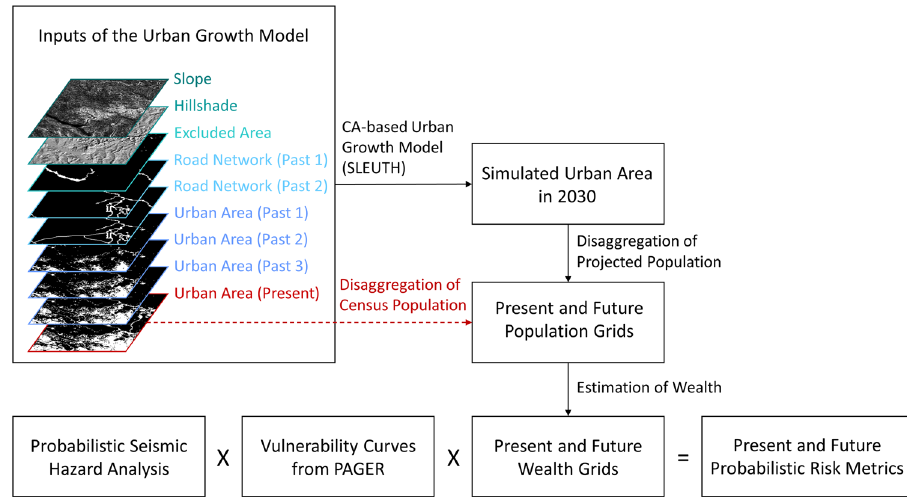
Fig. 1 Proposed framework for the estimation of present and future probabilistic seismic loss metrics using a macro-level approach. Inputs of the cellular automata (CA)-based urban growth model called SLEUTH are used to simulate the urban area in 2030. Present and future population are disaggregated to the present urban cells and future urban cells, respectively. Based on population grids, present and future wealth grids are obtained, and they are used in the estimation of present and future probabilistic risk metrics along with probabilistic seismic hazard analysis and vulnerability curves from Prompt Assessment of Global Earthquakes for Response